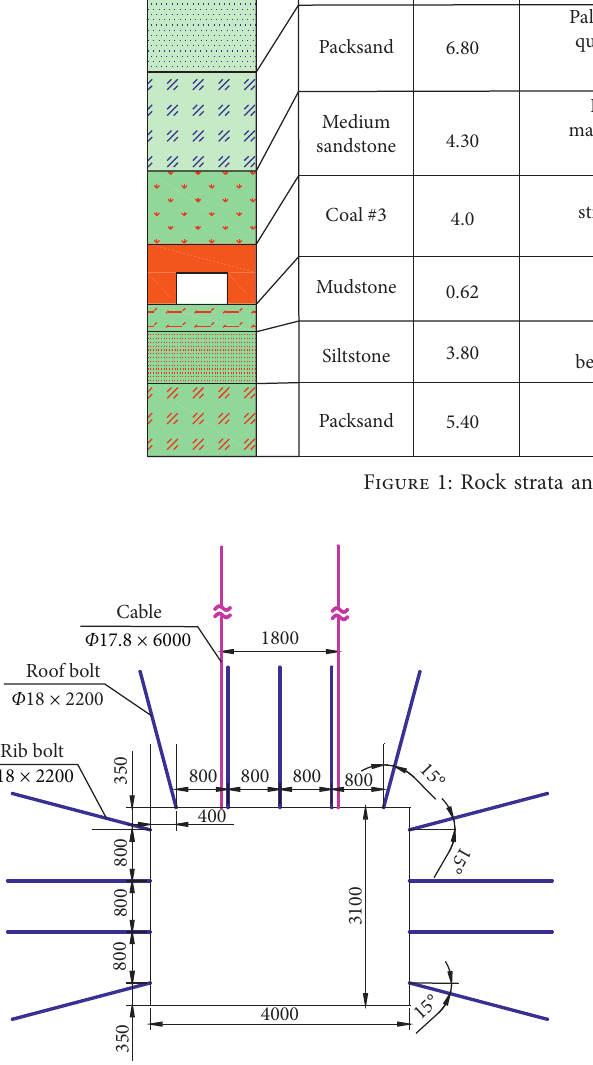
Figure 2: Section of the original support plan (unit: